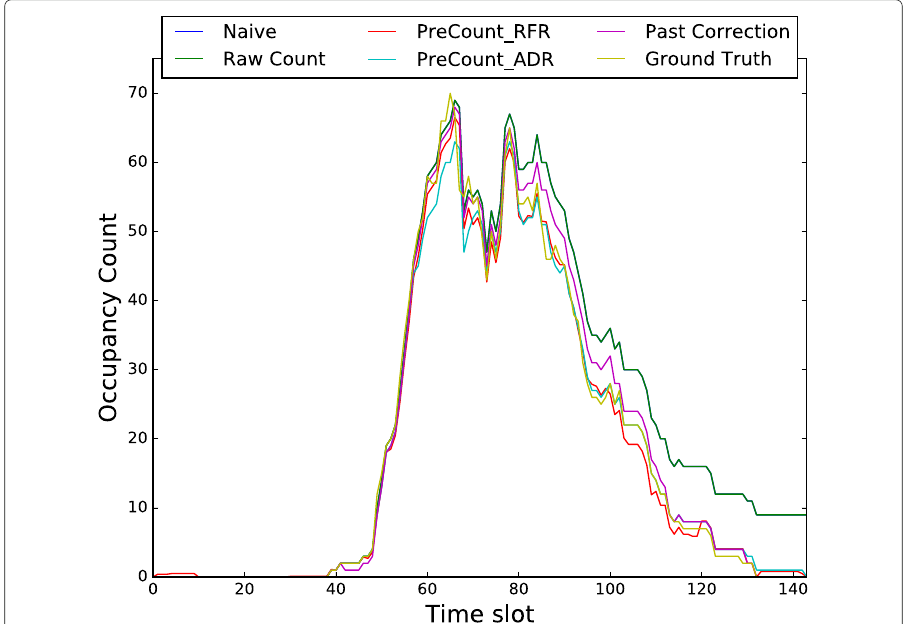
Fig. 9 Performance of each correction method in the OFFICE building case for 1-day ground truth